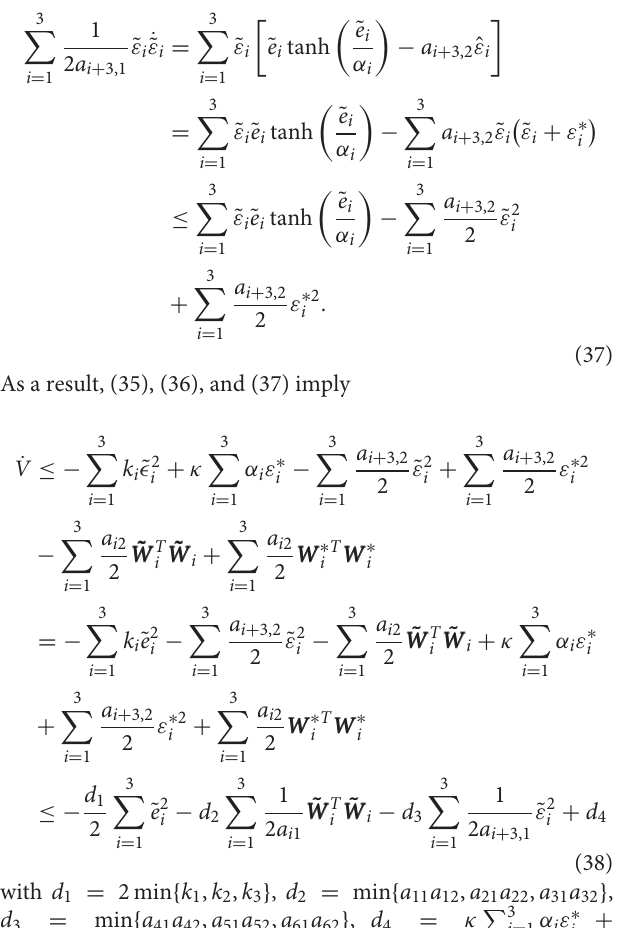
FIGURE 1 | Chaotic phenomenon of (2) in (A) x